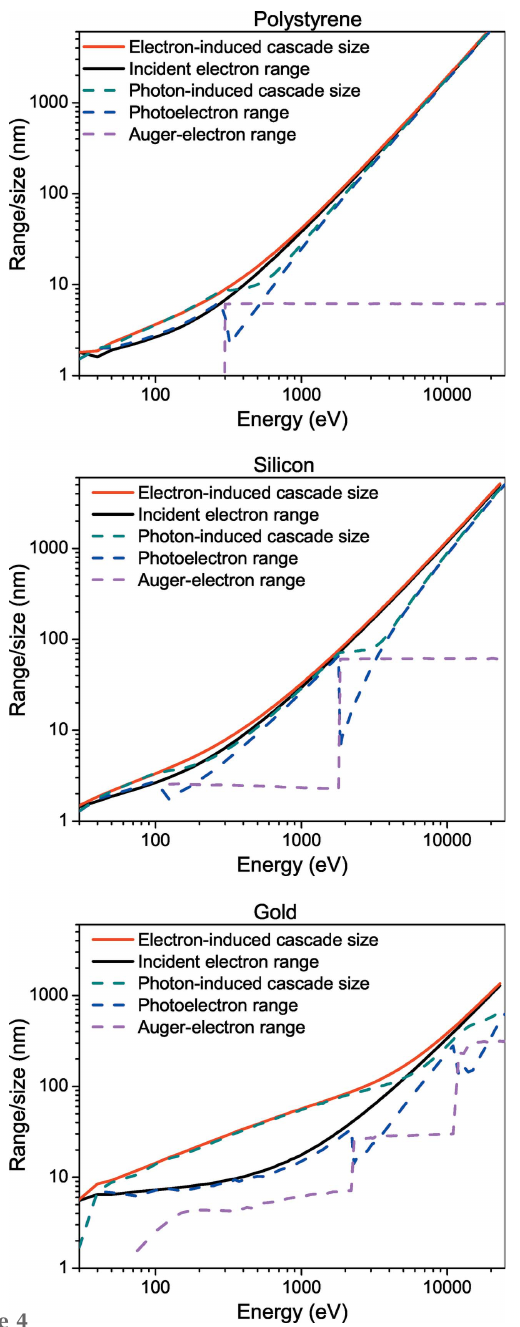
Figure 4 Parameters of cascades induced by an electron or a photon of given energy in polystyrene, silicon and gold. The x axis shows the energy of the impact particle (electron – solid curves; photon – dashed curves). The plot presents the incident electron range (depending on the incident electron energy), the photo-electron range (depending on the incident photon energy), the size of the electron-induced cascade and the size of the photon-induced cascade (see definitions in the text). Ranges of photon- induced Auger electrons are also shown.